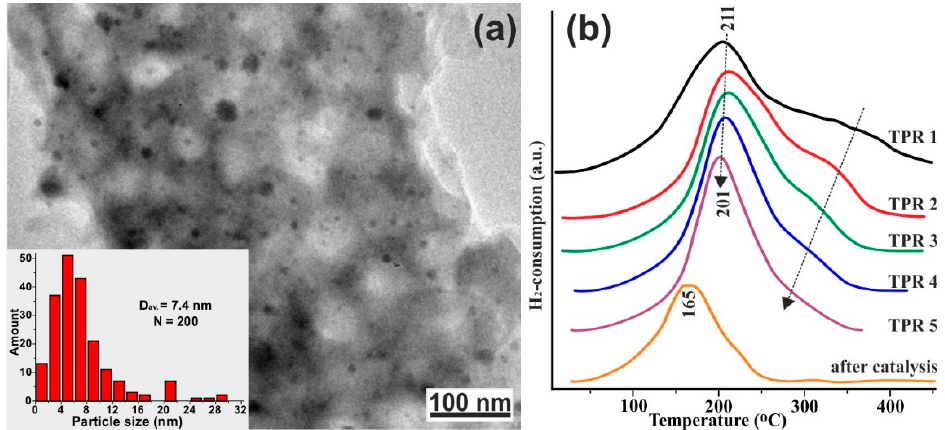
Figure 10. TEM image and silver particle size distribution of as-prepared Ag/P 2 O 5 /SiO 2 catalyst ( a ) and TPR profiles of the catalyst during a series of cyclic TPO/TPR treatments and after catalysis ( b ). Reprinted with permission from reference [89]. Copyright 2015 Trans. Tech. Publications.